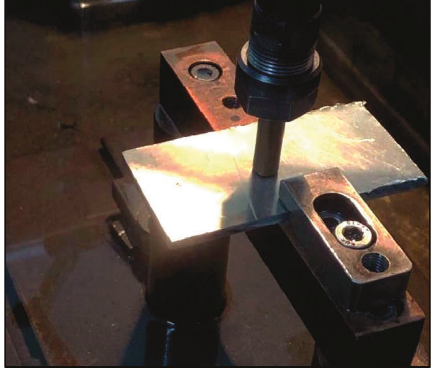
Figure 3: Workpiece is positioned for